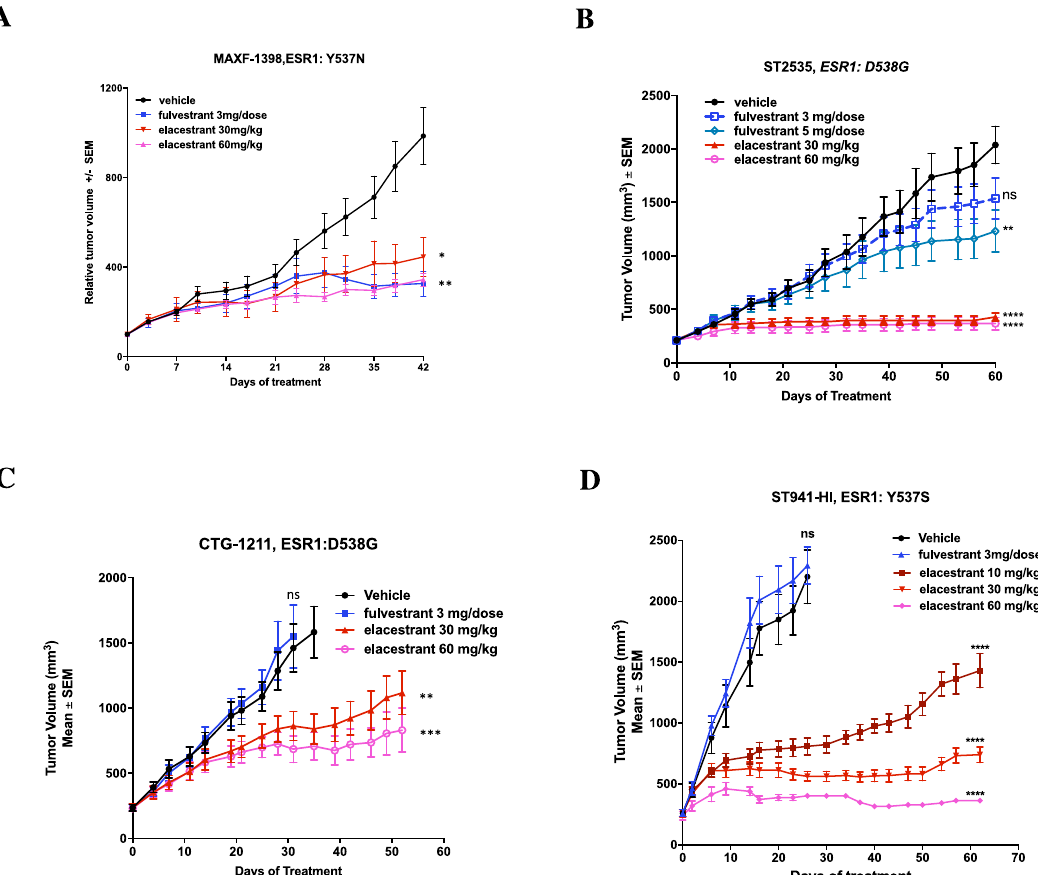
Fig. 5 Effect of elacestrant versus fulvestrant on tumour progression in endocrine-resistant PDX models. A Long-term study assessing changes in tumour volume over 42 days of treatment in MAXF-1398, an ER + model harbouring an ESR1 Y537N mutation and previously exposed to radiation and tamoxifen therapy but sensitive to fulvestrant ( n = 5 – 6 animals/arm). B , C Long-term study assessing changes in tumour volume of treatment in B ST2535-HI ( n = 7 – 10 animals/arm) and C CTG-1211-HI ( n = 9 animals/arm) PDX models that are ER + harbouring ESR1 D538G mutations and previously exposed to tamoxifen, AI and fulvestrant therapy. D Long-term study assessing changes in tumour volume over 64 days of treatment in ST941-HI, an ER + model harbouring an ESR1 Y537S mutation and previously exposed to fulvestrant ( n = 7 – 10 animals/arm). Mice were treated with vehicle control, fulvestrant (3 mg/dose) or elacestrant (10 mg/kg, 30 mg/kg or 60 mg/kg), as indicated. Data represent mean relative tumour volume (mm 3 ) ± SEM. ANOVA with a Dunnett ’ s post-test was carried out for group comparisons. p values * p < 0.05, ** p < 0.01, *** p < 0.001, **** p <